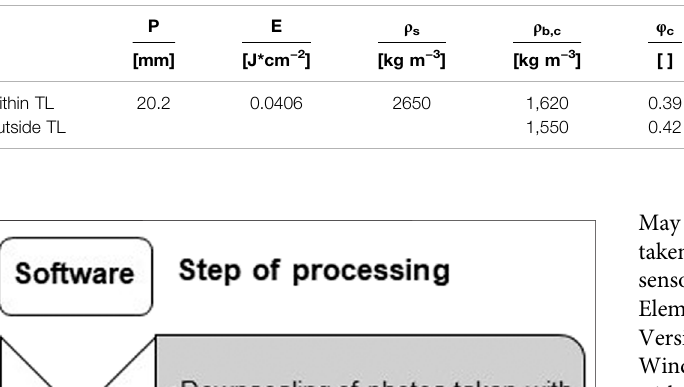
advantages of the SfM-photogrammetry in comparison to, e.g.,